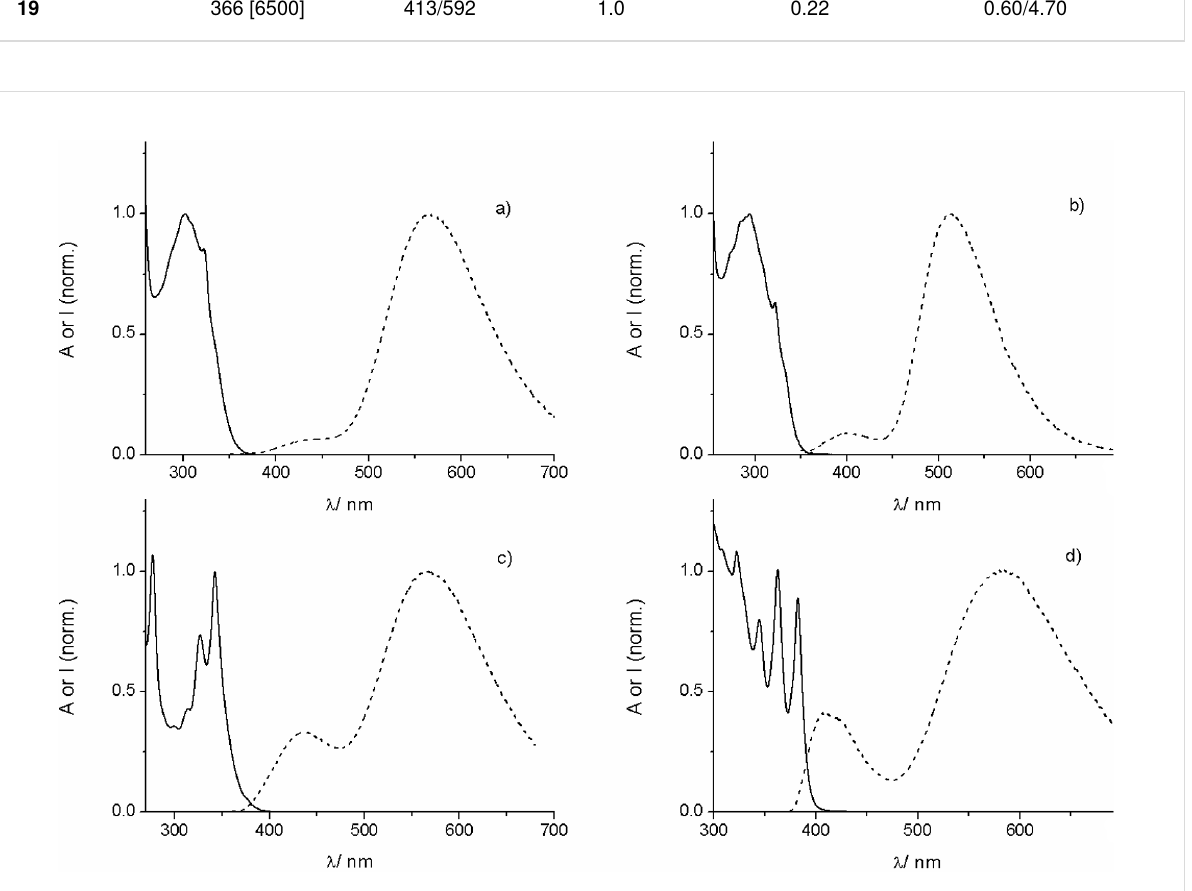
Figure 2: UV–vis absorption (solid line) and fluorescence (dashed line) spectra of a) 16 , b) 17 , c) 18 , and d) 19 in air-equilibrated acetonitrile (contain- ing 0.4 vol % DMF as